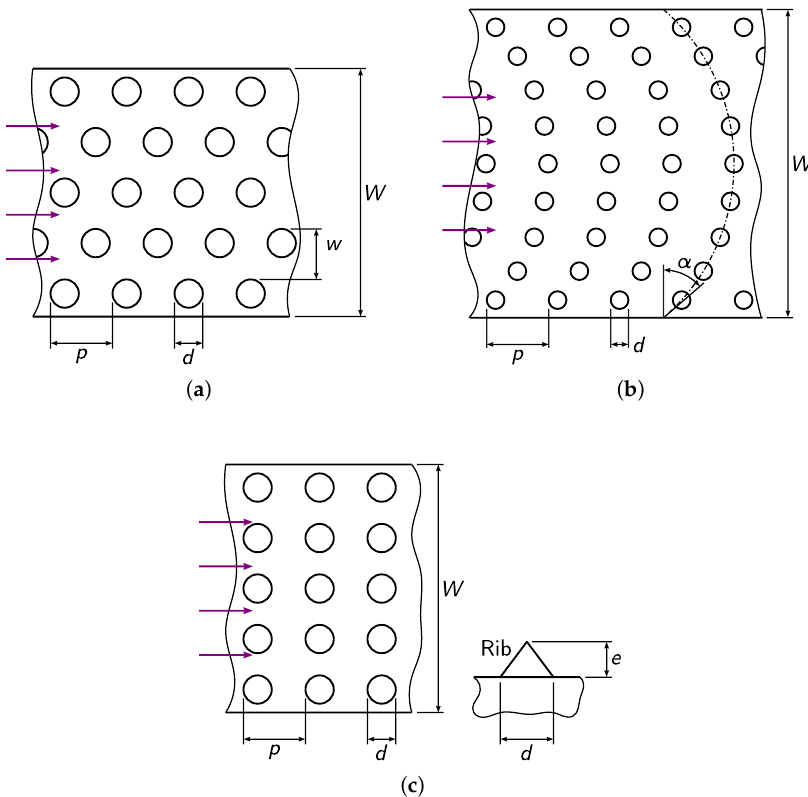
Figure 13. Rib arrangement and roughness parameters of absorber plates with round